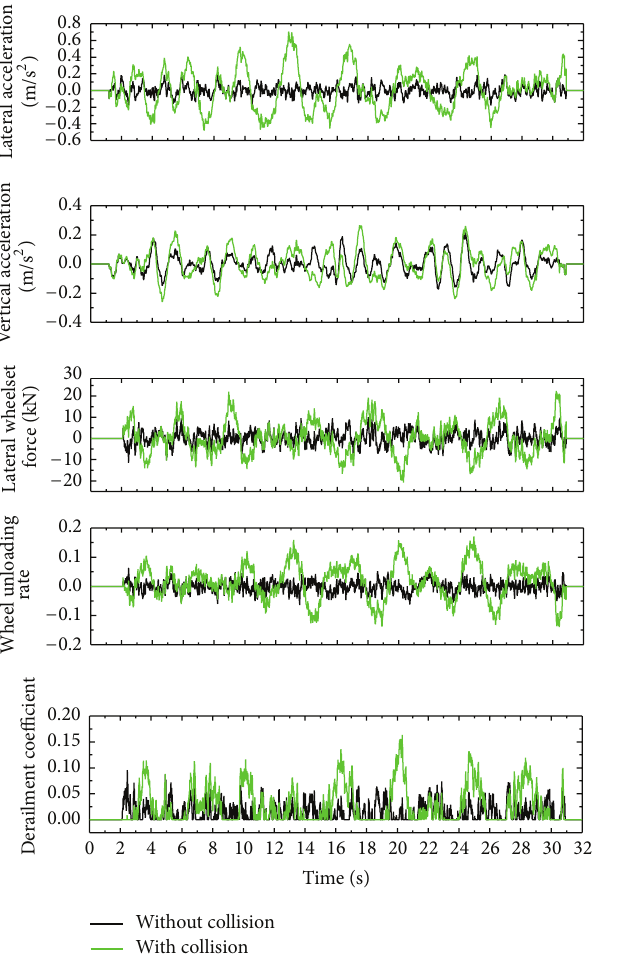
Figure 16: Responses of the motor car (the second train, 𝑋 2 = − 445 m, 80 km/h, in the down direction).